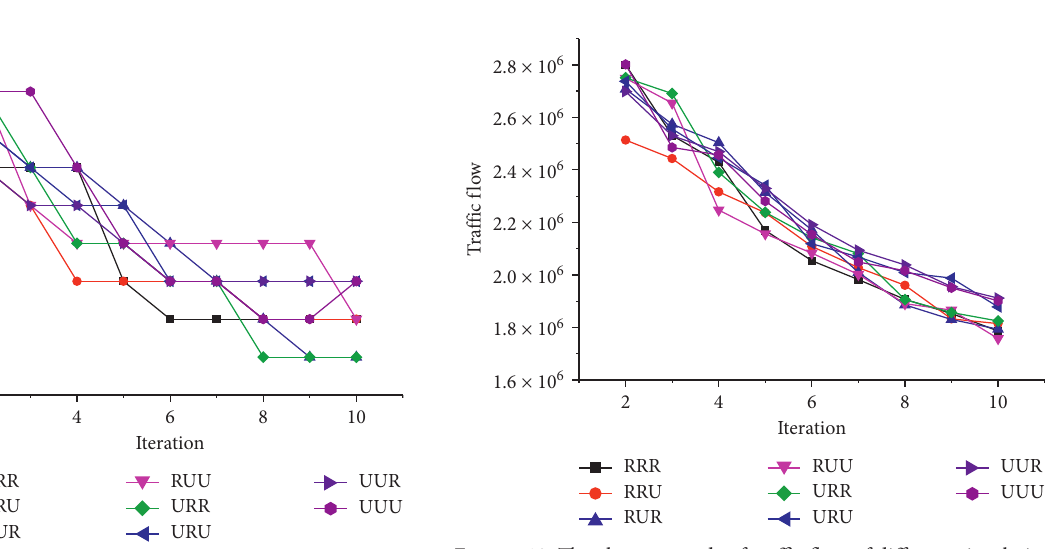
Figure 10: The change trends of D of different simulation scenarios.